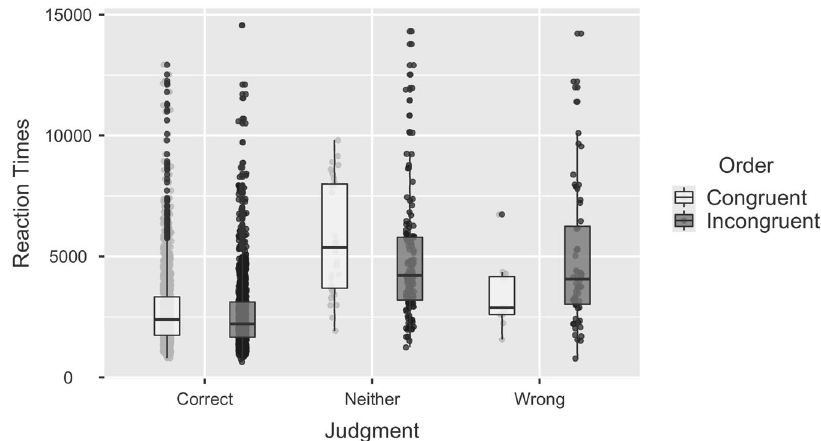
Fig. 5 Judgments and RTs split by order. They-axis shows inverse-transformed ms.